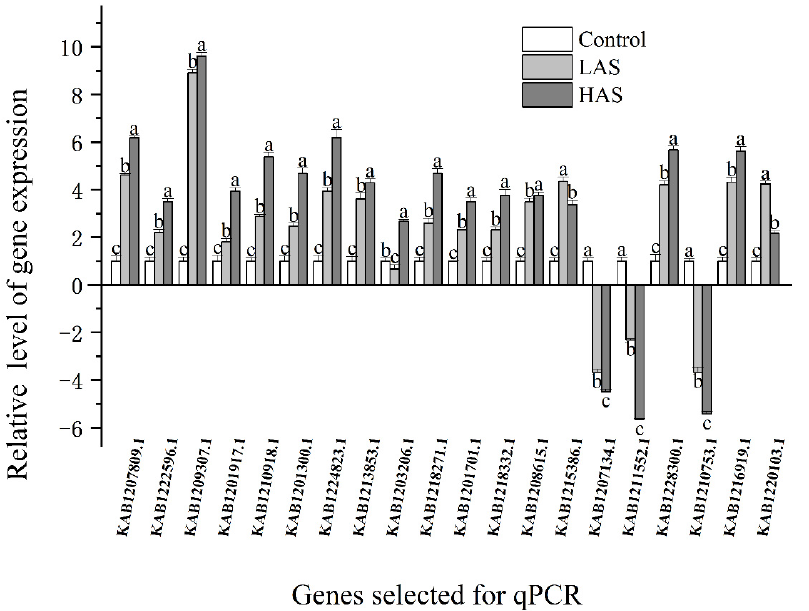
Figure 6. Verification of DEG expression levels through qRT-PCR. As assessed by Duncan’s multiple range test, the letters (a, b, and c) denote significant differences between treatments ( p < 0.05).